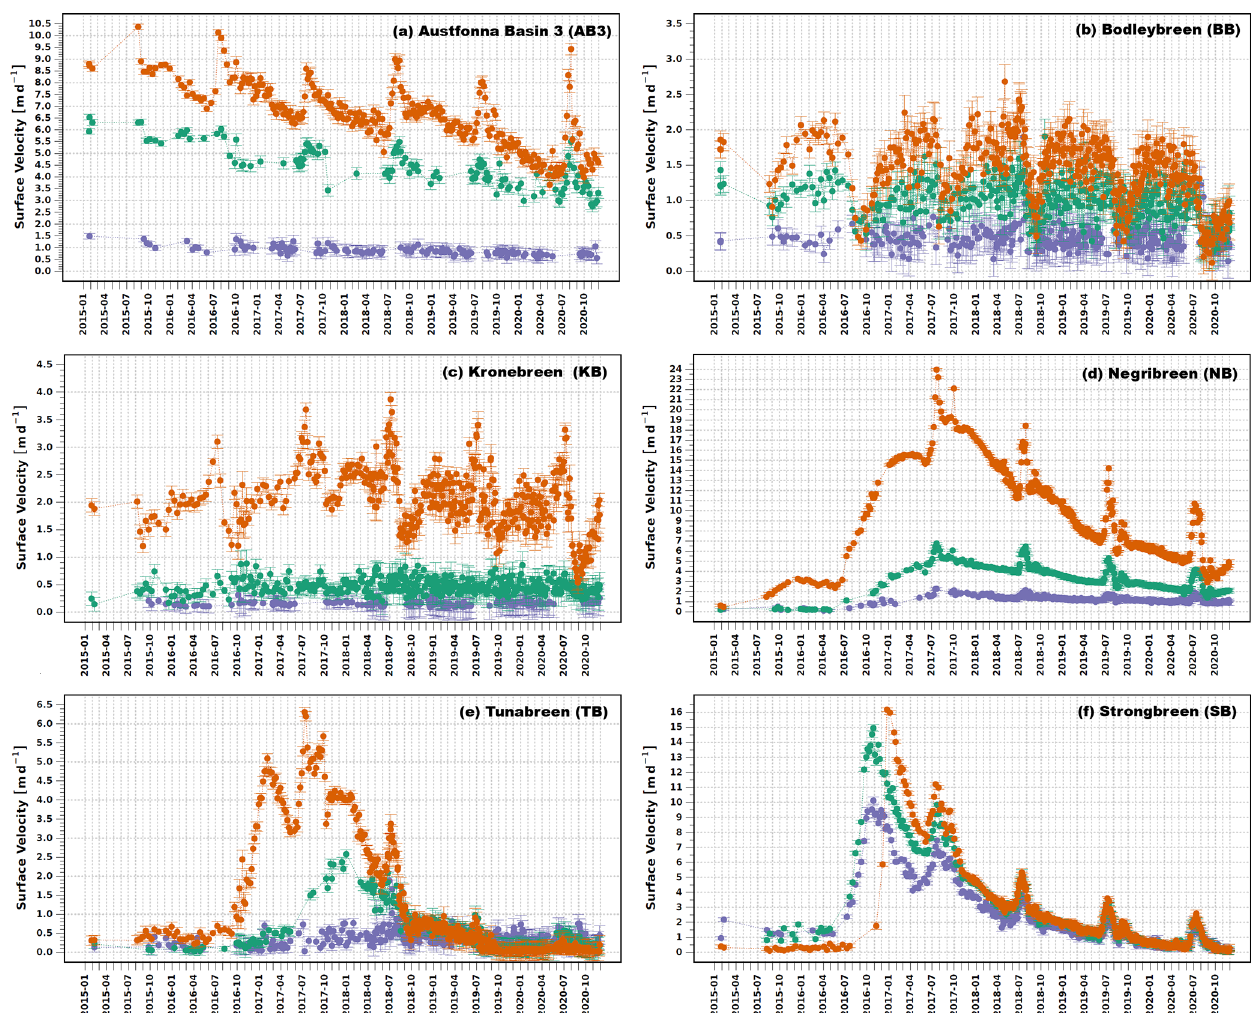
Figure 6. Velocity time series from Sentinel-1 (1 January 2015–30 November 2020) for six different glaciers in Svalbard. The color coding is the same as for the corresponding extraction points in Fig. 5. The color coding indicates the position of the corresponding measuring point on the glacier: purple = upstream; green = mid-glacier; orange =